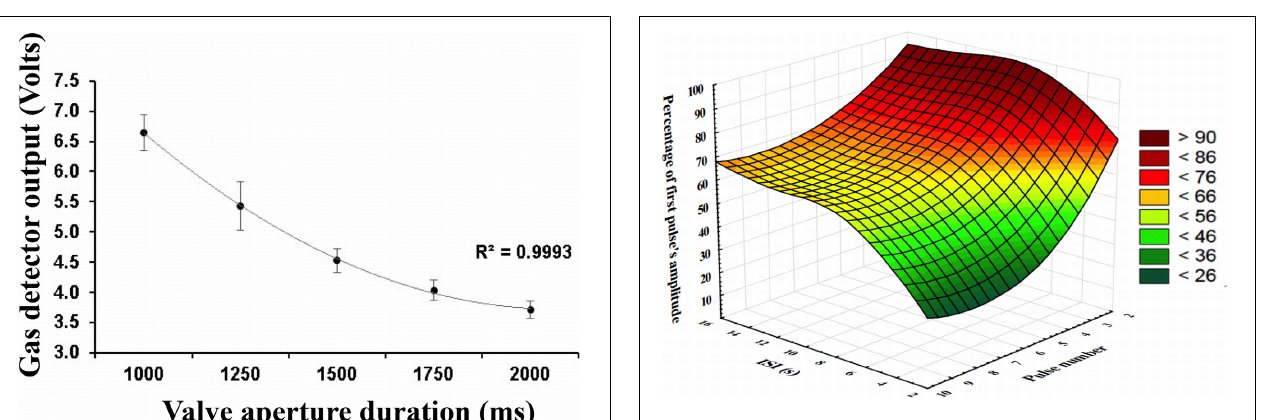
FIGURE 9 | Percentage of gas detector output changes as a function of the pulse number and the ISI. the odorants). Each odorant was delivered 10 times at 1 l.min − 1 flow rate for 2 s with an ISI duration of 4 s. Gas sensor output values obtained for one sequence of 15 odorants delivery are represented in Figure 10 . The gas detector output values aver- aged 500 ms before each valve aperture were used as baselines for each trial. For each odorants, we averaged the gas detector val- ues within successive 500 ms periods across the 10 trials during the 3 s following valve aperture. The resulting gas detector mean values averaged across odorants are represented in Figure 11